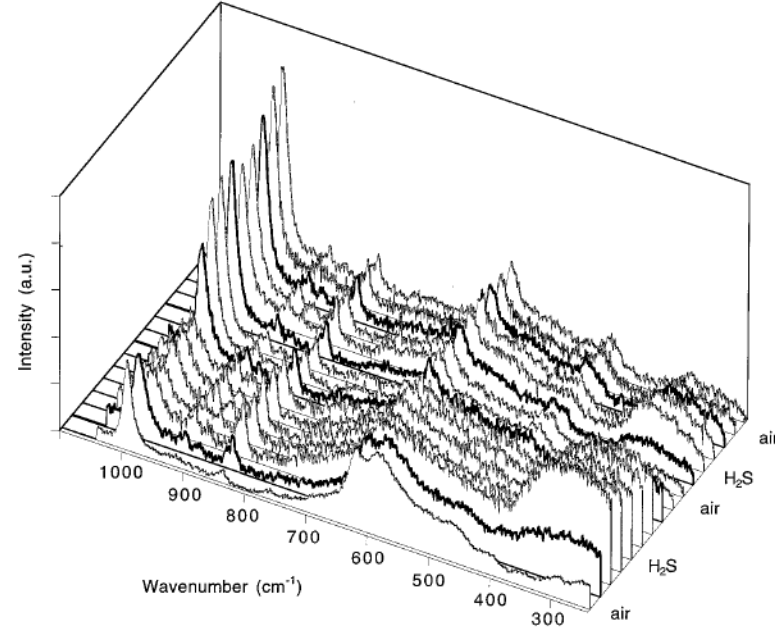
Figure 3. In situ Raman spectra of a SnO 2 pellet during exposure to two 300 ppm H 2 S-air cycles at 100 °C. Bold lines indicate the first spectra recorded after atmospheric change. Reproduced with permission from [22].